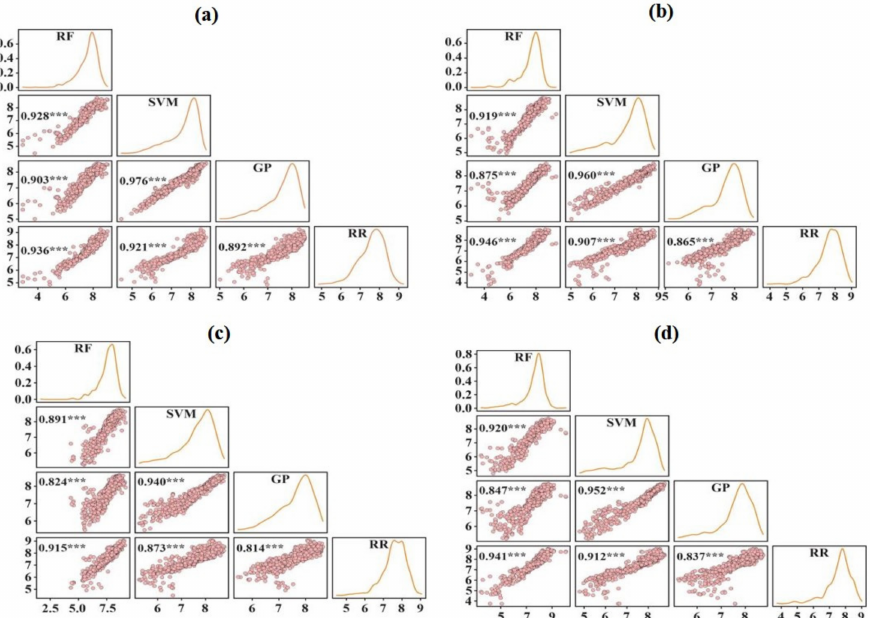
Figure A1. Regression plots, density curves, and correlation coefficient of the grain yield prediction generated by various machine learning methods at four growth stages under full irrigation treatment; ( a ) heading stage; ( b ) flowering stage; ( c ) early grain filling stage; ( d ) mid-grain filling stage significant (***) at p < 0.001. Abbreviations: RF, random forest; SVM; support vector machine; GP, Gaussian process; and RR, ridge regression.